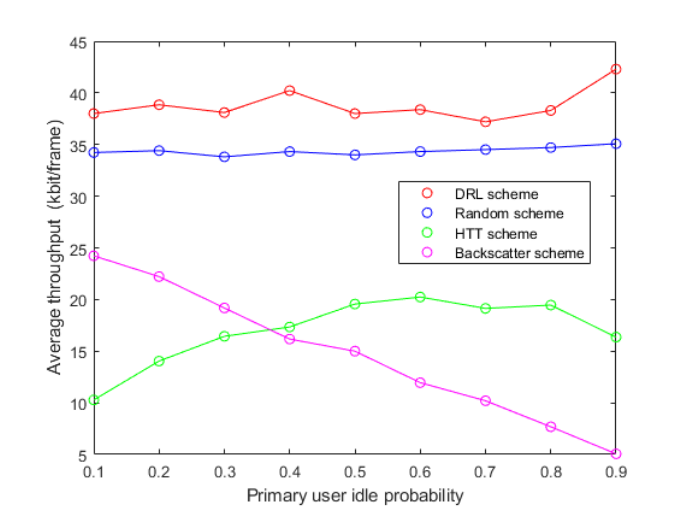
Figure 6. Average throughput of different schemes versus primary user idle probability.